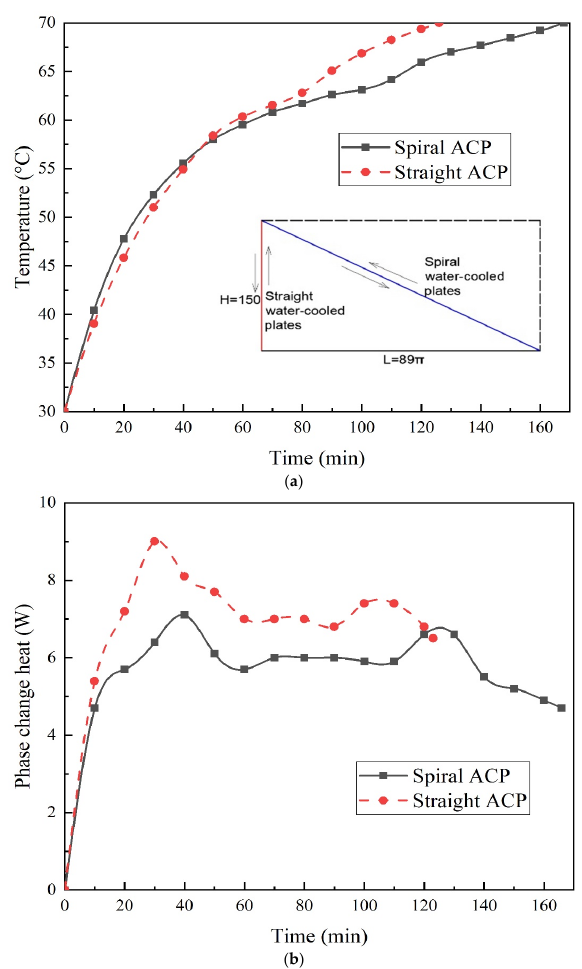
Figure 8. Comparison of thermal − protection performances with different ACP structures. ( a ) Inner − wall temperature. ( b ) Phase change of absorbed heat. The main reason for this is that the extended flow path might have increased the heat − transfer areas for the spiral ACP. With the same dimensions, the length of the spiral ACP corresponds to the diagonal length of the original column surface when unfolded, whereas the length of the straight ACP is only that of the ACP. Water is directed in both